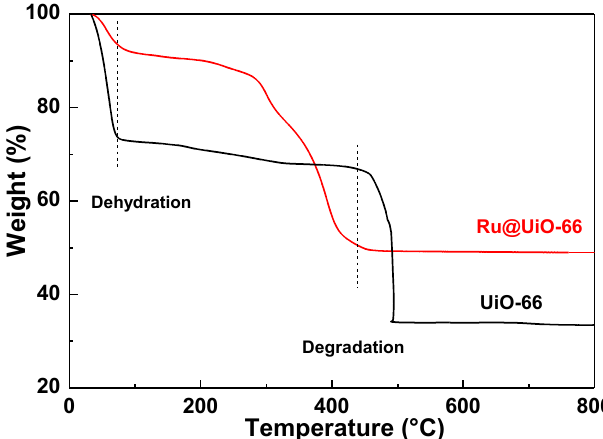
Figure 8. Thermogravimetric analysis (TGA) curves of Ru@UiO-66 and UiO-66.